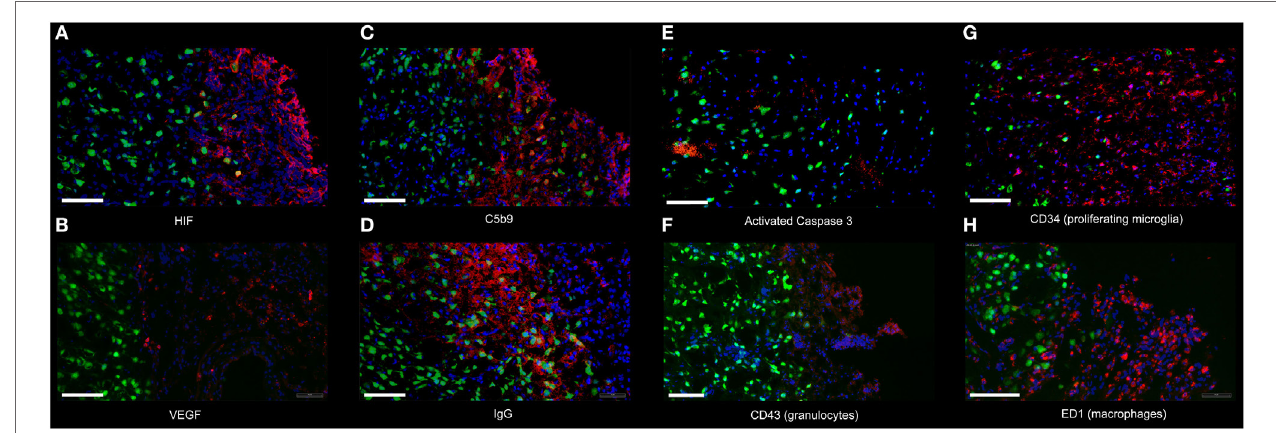
FigUre 3 | immunofluorescence of the analyzed proteins . The image illustrates representative immunofluorescence to the following proteins: (a) HIF-1 α (HIF) (day 1), (B) VEGF (day 1), (c) C5b-9 (day 1), (D) IgG (day 1), (e) Activated Caspase 3 (day 1), (F) Granulocytes (CD43, day 1), (g) Proliferating microglia (CD34, day 7), and (h) Macrophages (ED1, day 7) (all red, respectively) at 10 × amplification from normoxic animals. NeuN was used to label neurons (green). DAPI was used as counterstaining for all cells (blue). All pictures are taken from the peri-lesional area; the cavity is located to the right of each picture. Scale bar = 100 μ m.